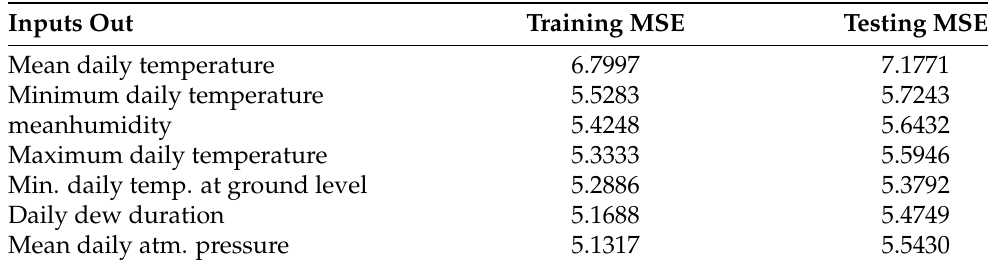
Table A12. The results of the sensitivity analysis for the prediction of the minimum daily